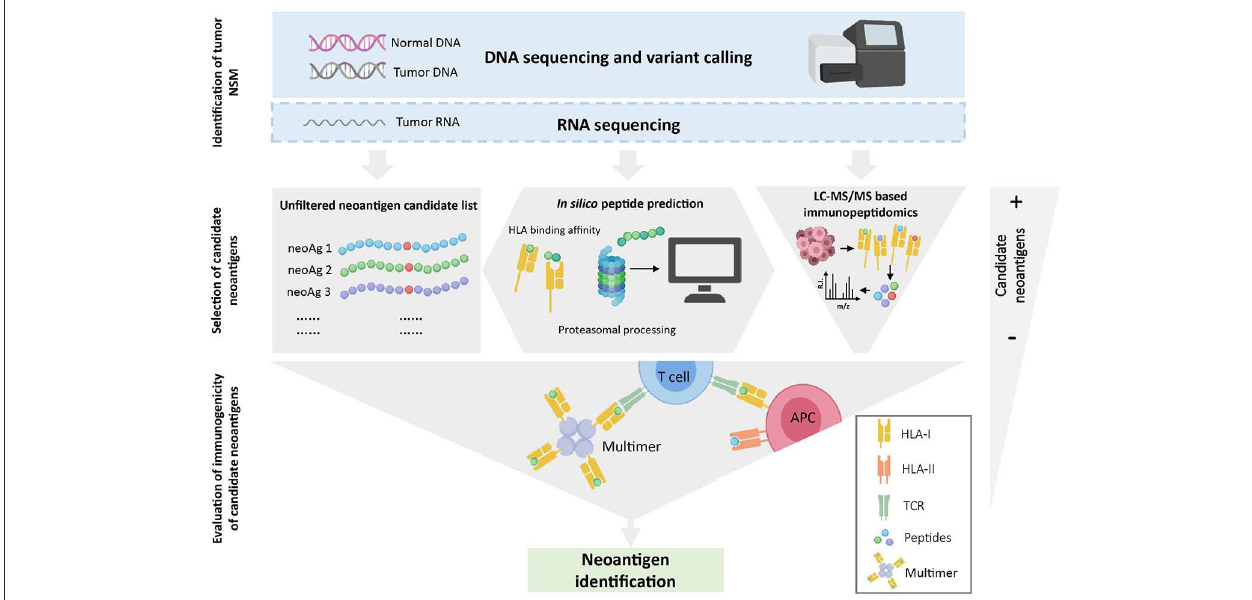
FIGURE 1 | Overview of neoantigen identification using tumor WES. WES is performed on tumor and normal DNA to identify tumor-specific NSM. When available, RNAseq is used to select mutations that are expressed. Once NSM are identified, three strategies can be used to select the list of candidate neoantigens that will be assessed for immunogenicity. The gray-filled shapes depict how each selection strategy will dictate the final number of candidate peptides to be evaluated. Note that in silico prediction initially increases the number of potential candidates but, after a ranking-based selection of peptides, this number decreases substantially. Finally, the immunogenicity of the selected candidate peptides is evaluated with different immunological screening